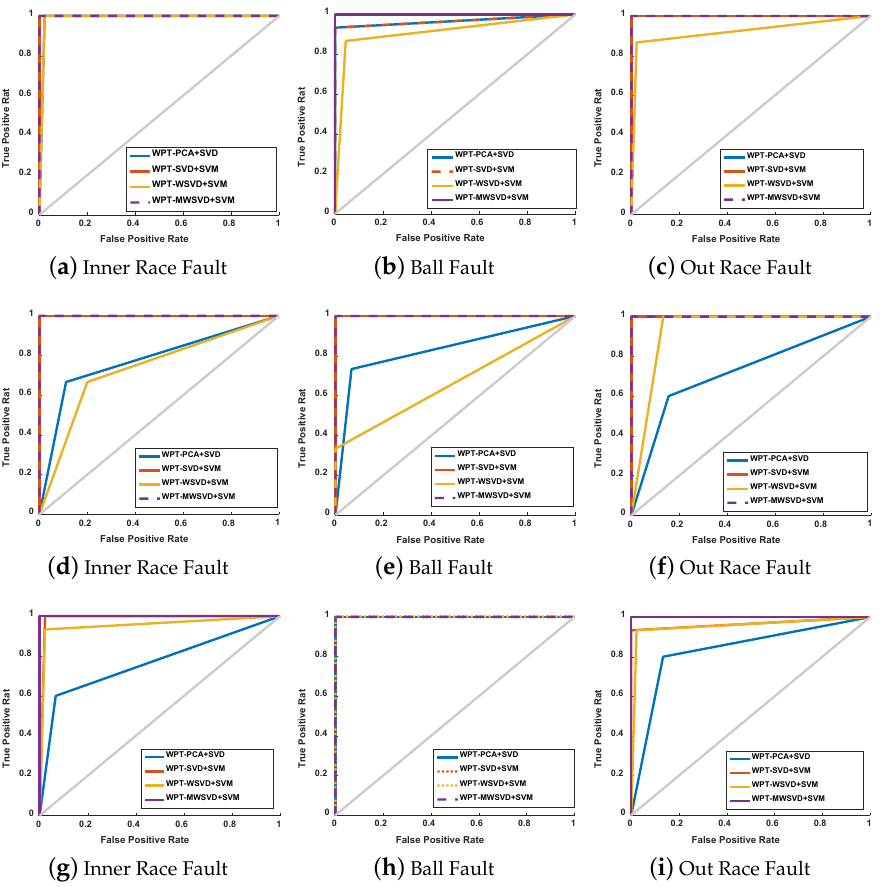
Figure 13. ROC curve diagram of the four algorithms: the minor fault diagnosis of the bearing inner race ( a ), Ball ( b ) and outer race ( c ); the general fault diagnosis of the bearing inner race ( d ), Ball ( e ) and outer race ( f ); the serious fault diagnosis of the bearing inner race ( g ), Ball ( h ), and outer race ( i ).